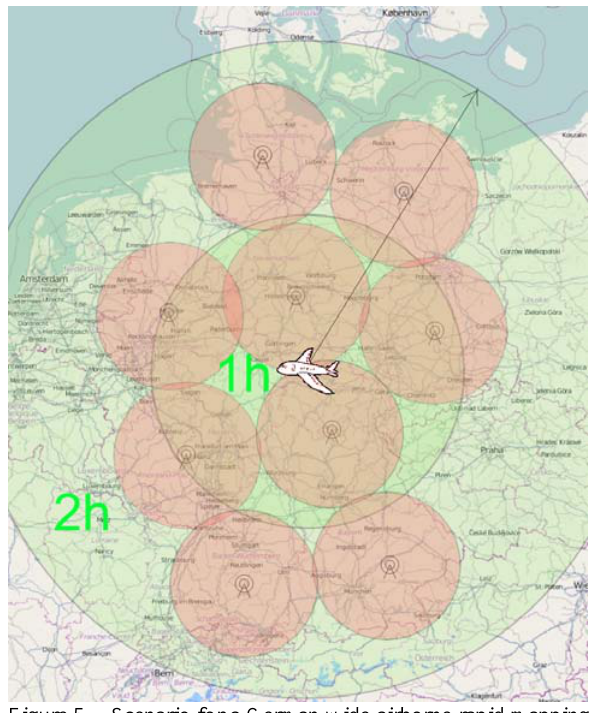
Figure 5. Scenario for a German wide airborne rapid mapping service based on nine stationary receiving stations and one airplane (Scenario